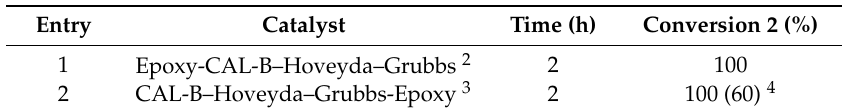
Table 6. Immobilized lipase-Hoveyda–Grubbs second-generation catalyst conjugates in aqueous metathesis reaction of 1 1